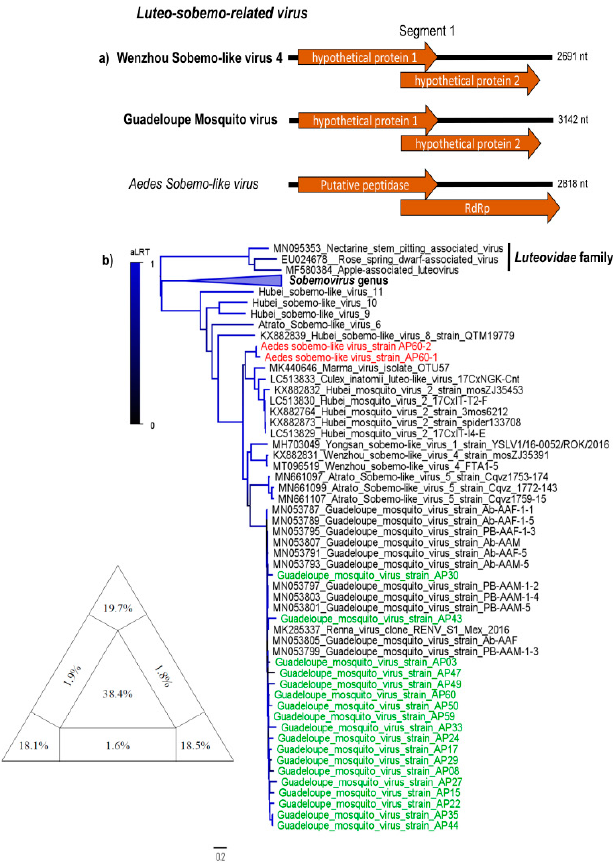
Figure1. Luteo-sobemo-related viruses genomes map and phylogeny. ( a ) Open read-frame organization of closest related virus to Aedes sobemo-like virus and Guadeloupe mosquito virus . ( b ) Nucleotide maximum likelihood tree based on segment 1 for Sobemo-like viruses and Luteovirus and Sobemovirus genus. Aedes sobemo-like virus and Guadeloupe mosquito virus sequenced in this study are highlighted in orange and green, respectively. The diagram in the base of the tree is the likelihood map of the nucleotide alignment of genomes of Luteo-sobemo-related viruses. The likelihood quartet mapping is a method that allows to visualize the tree-likeness of all quartets in a single graph and provide a direct measure of the phylogenetic signal in an alignment. The triangle shows the location of all quartets calculated with the alignment used to infer the ML tree. Values in the center of the triangle represent the percentage of unresolved quartet trees (star-like trees), values in the vertices represent the percentage of fully resolved trees and values in the intermediate areas (between vertices) are the percentage of conflicting trees. The analysis was performed using GTR + gamma correction model as is implemented in the tree puzzle software v 5.3 (http://www.tree-puzzle.de).